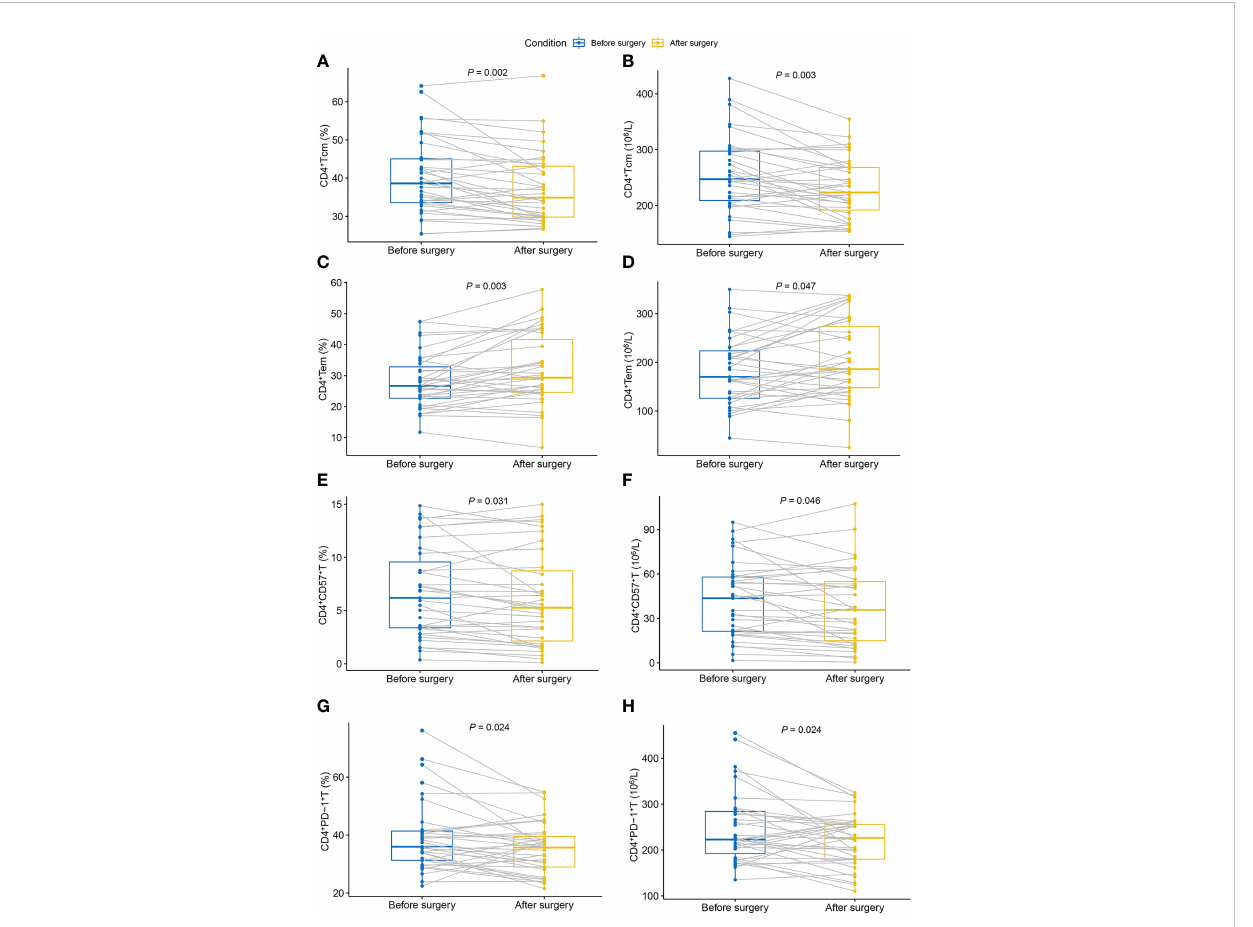
FIGURE 2 Dynamic changes in circulating CD4 + Th cells in patients with breast cancer after surgery. (A) Proportion of CD4 + Tcm; (B) absolute count of CD4 + Tcm; (C) proportion of CD4 + Tem; (D) absolute count of CD4 + Tem; (E) proportion of CD4 + CD57 + T; (F) absolute count of CD4 + CD57 + T; (G) proportion of CD4 + PD-1 + T; (H) absolute count of CD4 + PD-1 + T. Tem, effector memory T cells; Tcm, central memory T cells; Th, helper T